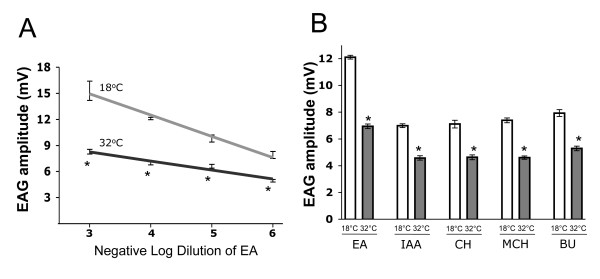
Go signaling is required for normal EAG responses to diverse odorants. (A) EAG responses evoked by four different concentrations of ethyl acetate (EA) in Gal80ts20/Or83b-Gal4; UAS-PTX/+ flies are significantly (p < 0.0001) higher in the absence of PTX expression (18°C) than in the presence of PTX expression (32°C). (B) EAG responses evoked by a 10-4 concentration of ethyl acetate (EA), a 10-4 concentration of isoamyl acetate (IAA), a 10-4 concentration of cyclohexanone (CH), a 10-4 concentration of 4-methylcylcohexanol (MCH), and a 10-3 concentration n-butanol (BUT) in Gal80ts20/Or83b-Gal4; UAS-PTX/+ flies are significantly (p < 0.0001) higher in the absence of PTX expression (18°C) than in the presence of PTX expression (32°C). For a given genotype, odor concentration, and temperature, at least 8 EAG recordings from minimum 4 flies were analyzed. Asterisks denote a significant (p < 0.05) change. All values are mean ± S.E.M.